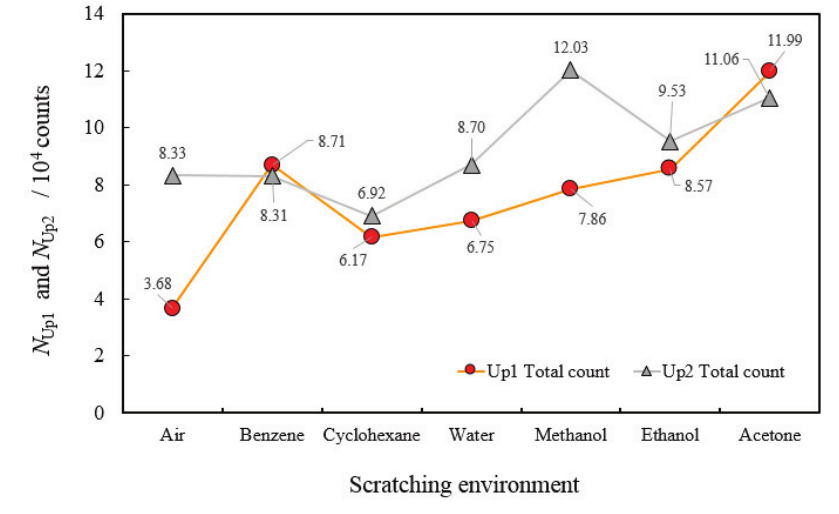
Figure 7. Plots of the total count of PE electrons emitted during the Up1 and Up2 temperature scans, N Up1 and N Up2 , respectively, against the scratching environment.